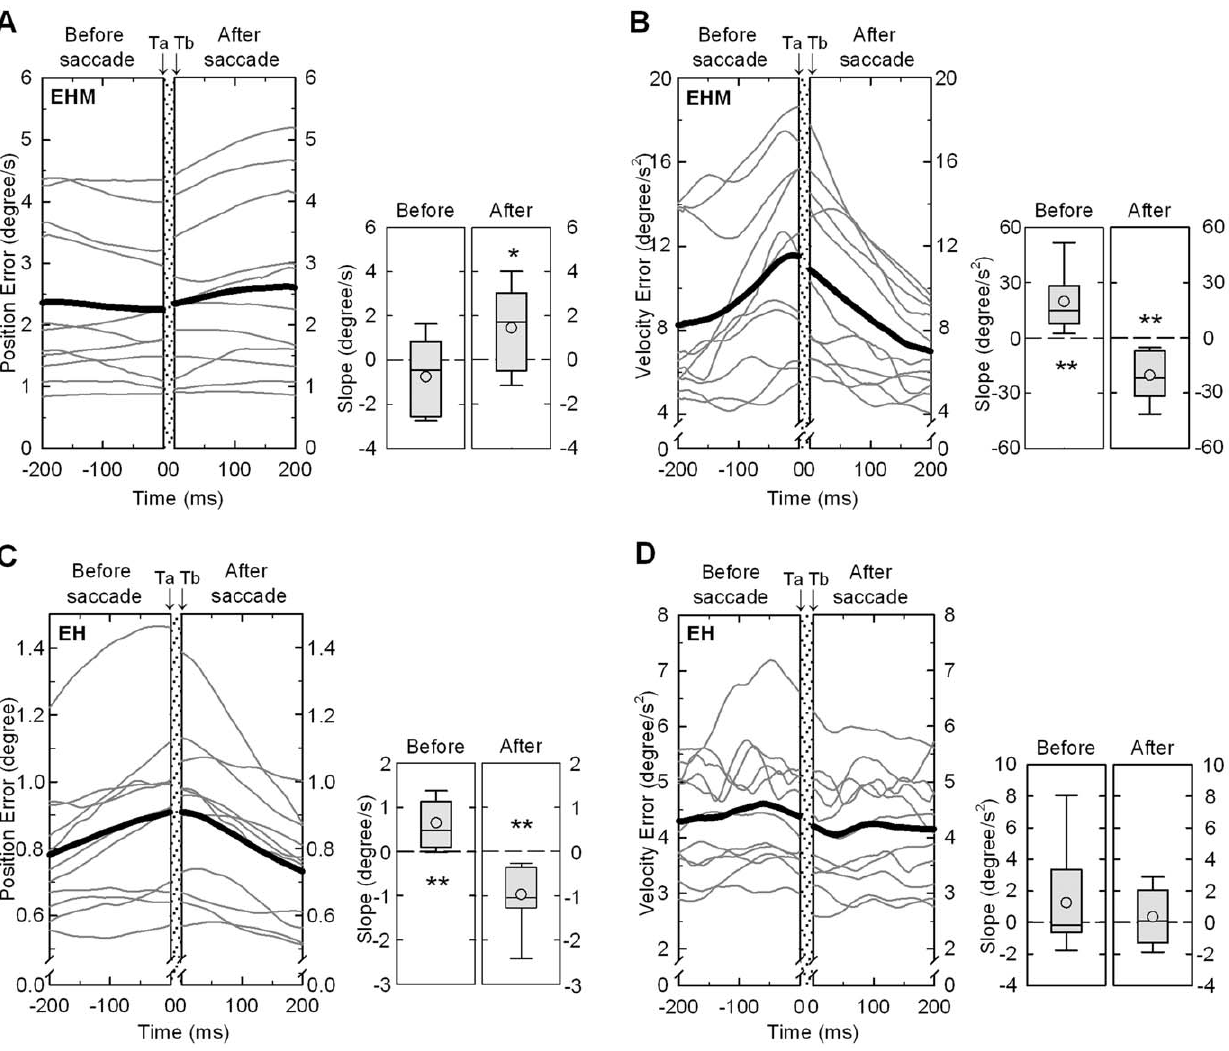
Figure 8. Temporal dispersion and regressive slope for manual positional and velocity errors in the defined window. (A) Positional errors, and (B) velocity errors in the EHM condition; (C) positional errors, and (D) velocity errors in the EH condition. For each plot of (A)–(D), individual (thin line) and mean (thick line) temporal error dispersions are displayed in the left panel. The shadowed area (from time point Ta to Tb) represents an occurrence of a saccade event. The box-plots in the right panel of (A)–(D) show the median (central line), lower and upper quartile (lower and upper lines), and the mean value (circle) for regressive slope of manual tracking errors before and after the saccade event. The lines extending from each end of the box represent the minimum and maximum observations. Asterisks in the box-plots denote significant differences of the regression slope from zero. ( * : P , 0.05; ** : P , 0.01; ** : P , 0.01).